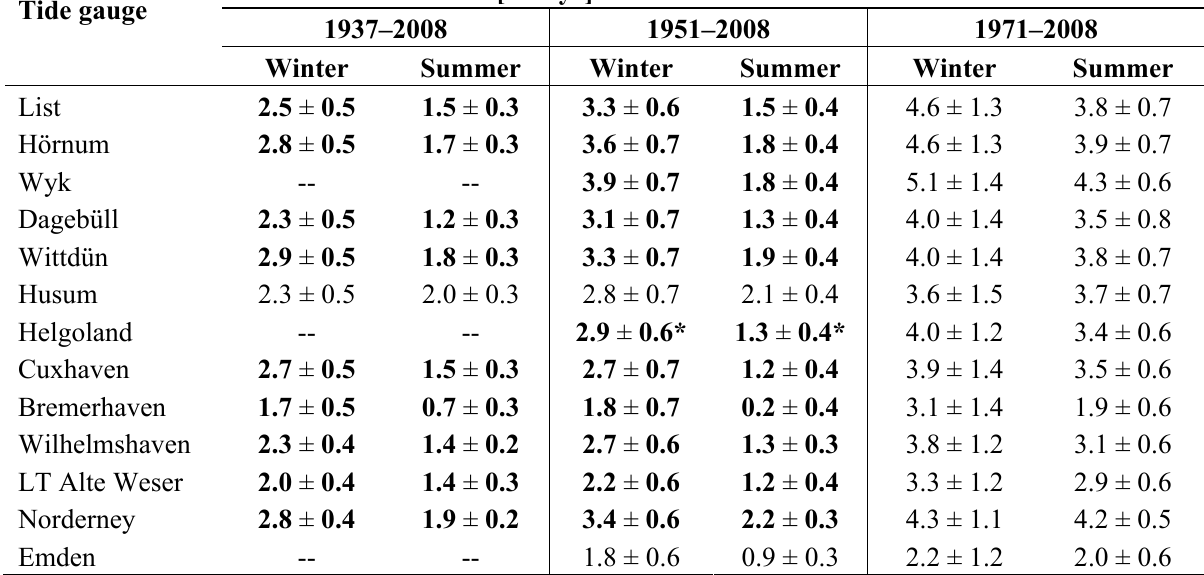
Table 1. Linear trends for different common periods differentiated in winter (N–A) and summer season (M–O). The values are marked in bold if trends of the two considered seasons differ